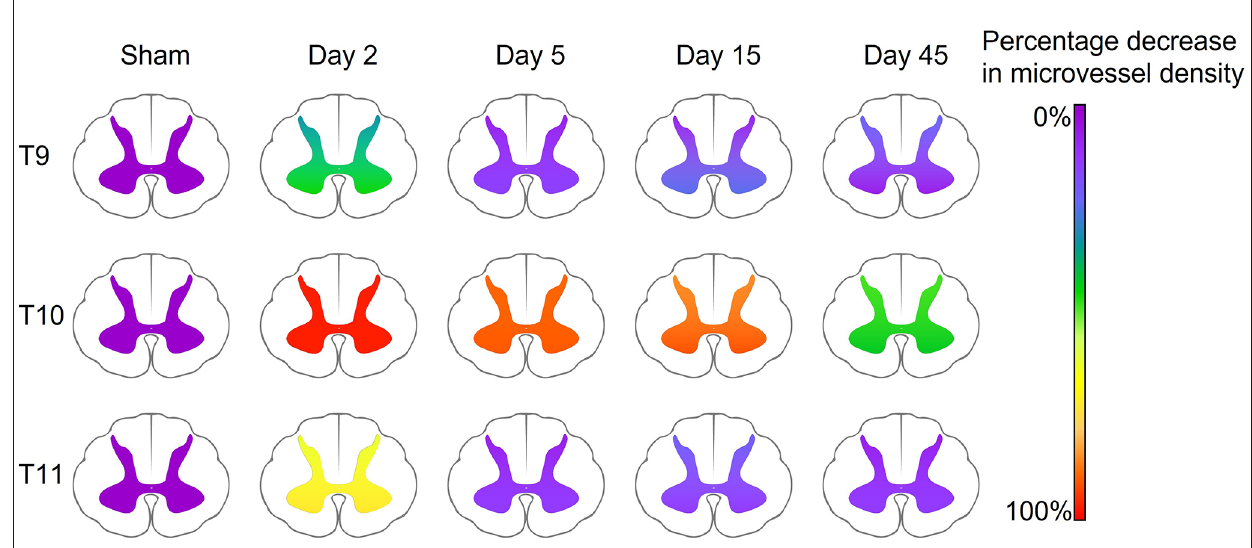
FIGURE7 Summary schematic demonstrating the percentage decrease in microvessel density (number of vessels mm − 2 ) in the ventral and dorsal grey matter compared to sham animals in key spinal cord segments. The injury epicentre (T10) demonstrated the most severe changes, with a 99% and 95% decrease in vessel density at day 2, and a 44% and 49% decrease at day 45 (ventral and dorsal grey matter respectively). Microvessel density decreased at day 2 in perilesional areas (47% and 34% at T9, and 75% and 62% at T11, ventral and dorsal grey matter respectively), however returned to only a < 25% reduction in microvessel density by day